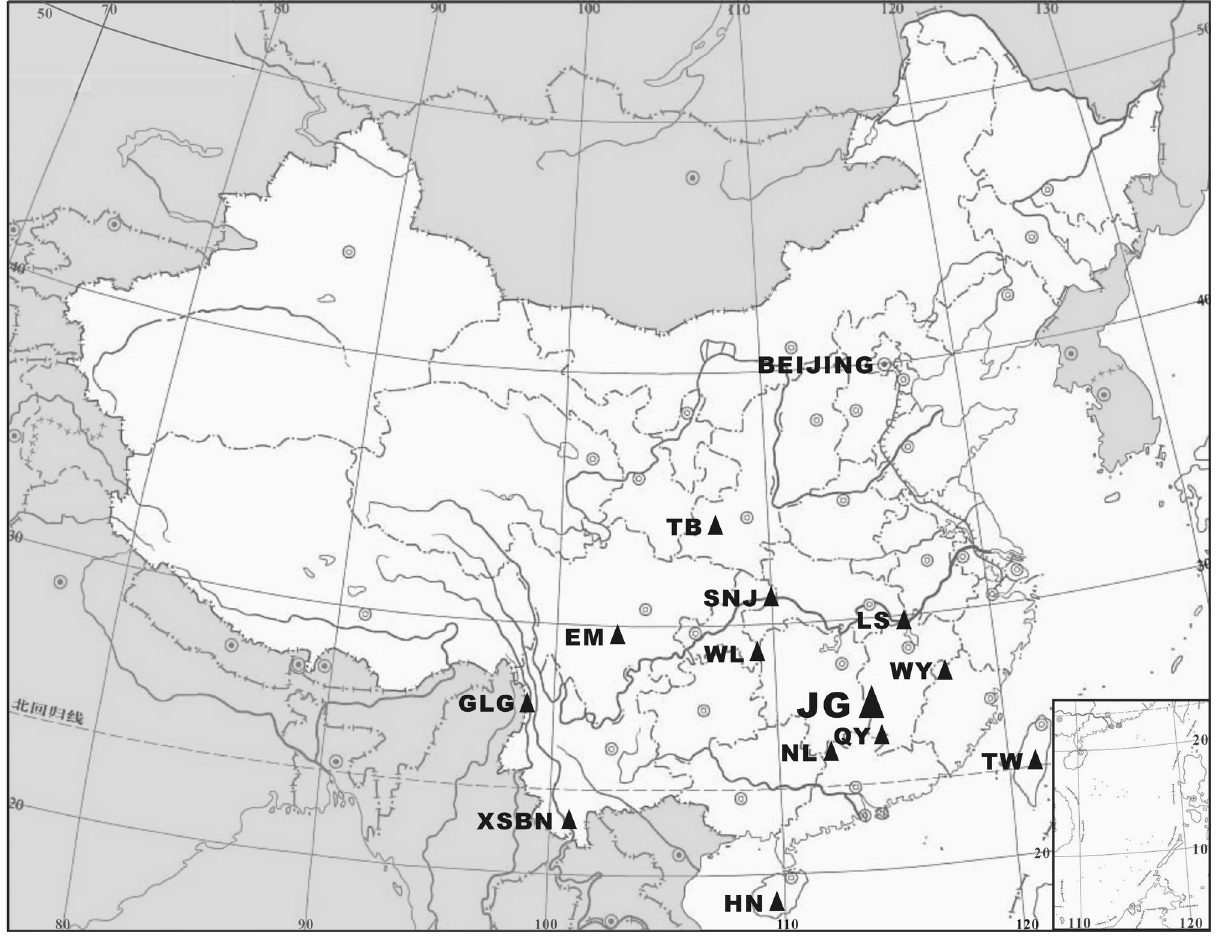
Figure 1. Map showing the locations of Mount Jinggangshan region and other twelve mounts in China. Notes: JG: Mount Jinggangshan region; QY: Mount Qiyunshan; LS: Mount Lushan; NL: Nanling Mountains; WY: Mount Wuyishan region; WL: Wuling Range; SNJ: Mount Shennongxia; EM, Mount Emeishan; TW: Taiwan Mountains; HN: Hainan Mountains; TB: Mount Taibeishan; XSBN: Mount Xishuangbangna; GLG: Mount Gaoligongshan. doi: